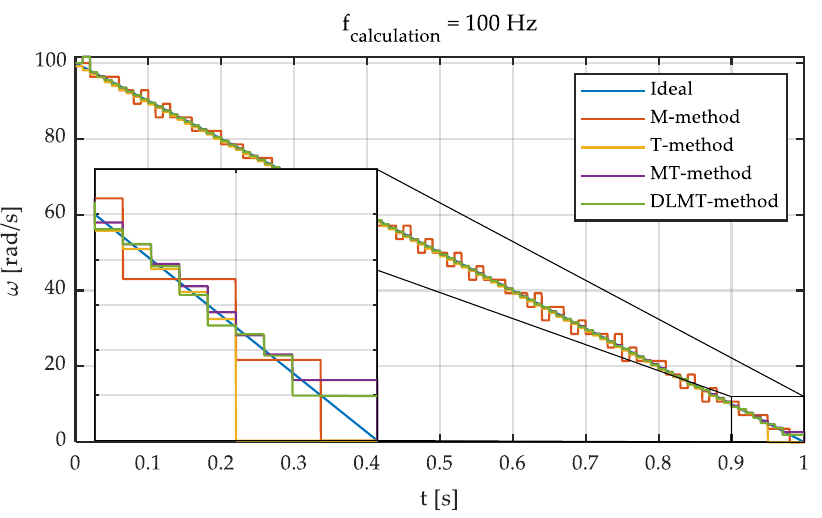
Figure 7. Simulation with different methods. d ω /d t = –100 rad/s 2 . ω 0 = 100 rad/s.